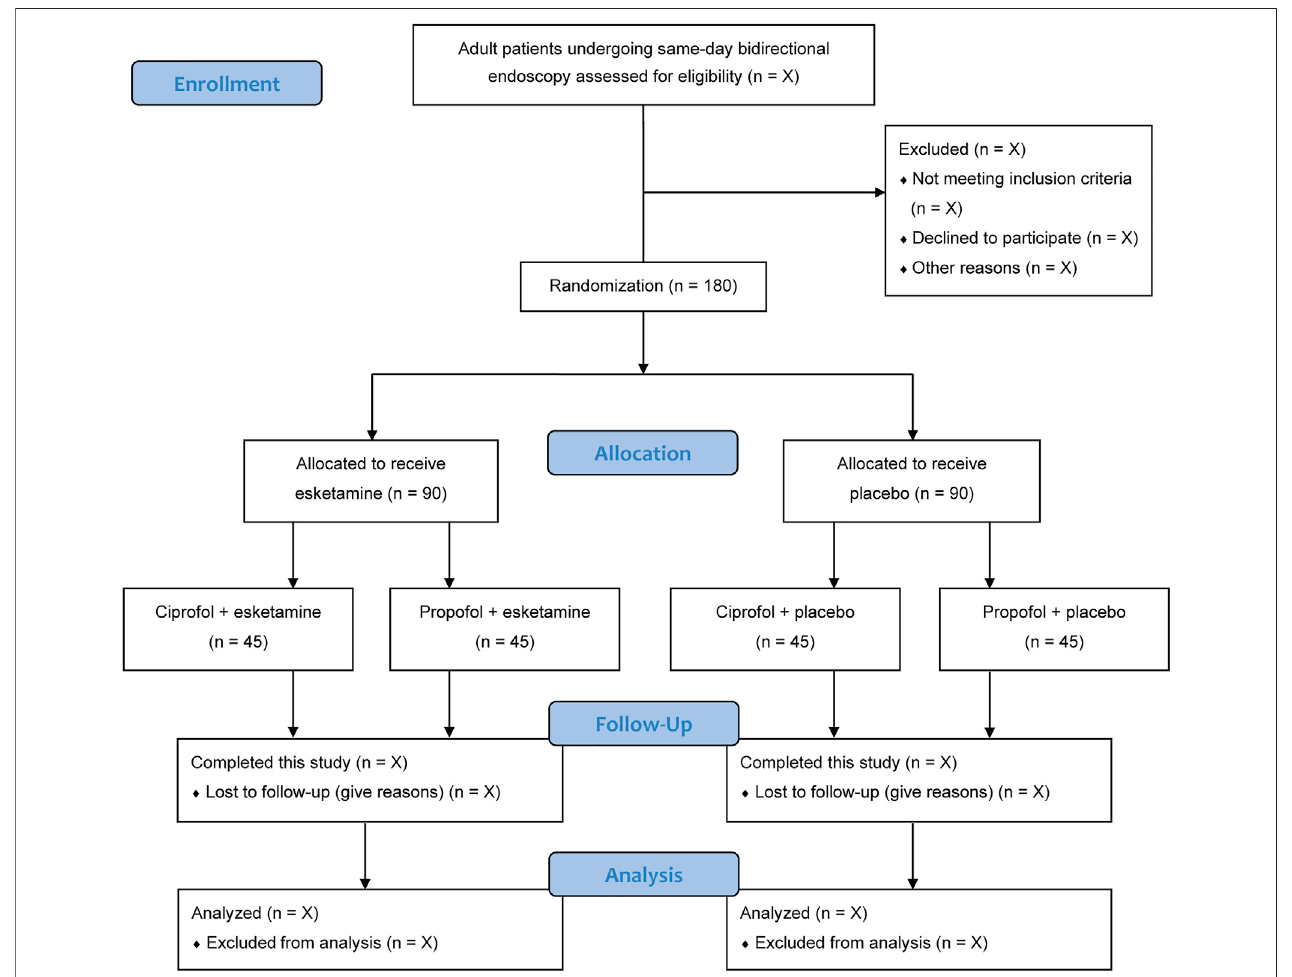
FIGURE 1 | Flow chart of